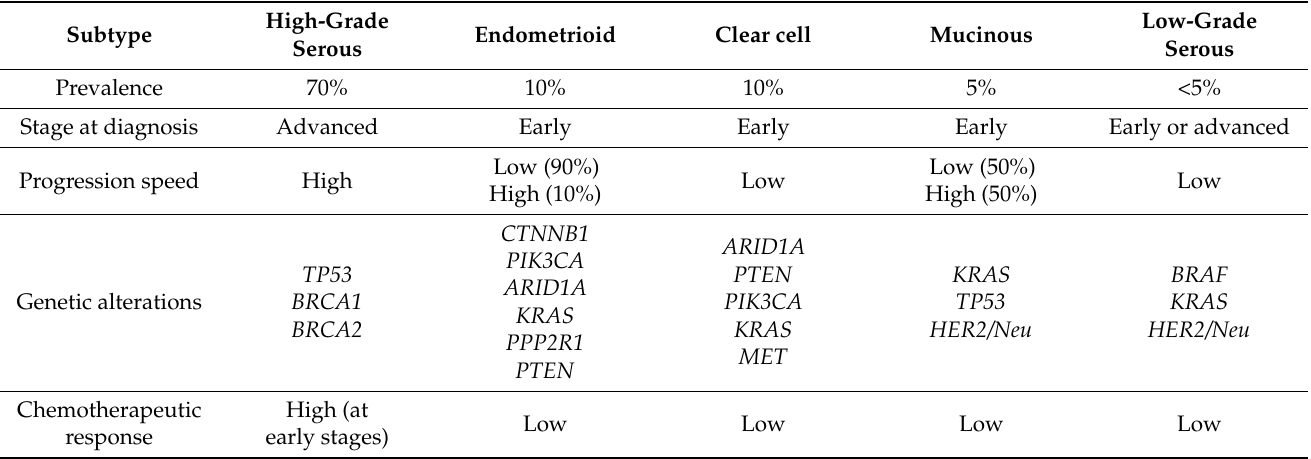
Table 1. Clinical characteristics and genetic alterations in the five different subtypes of epithelial OC